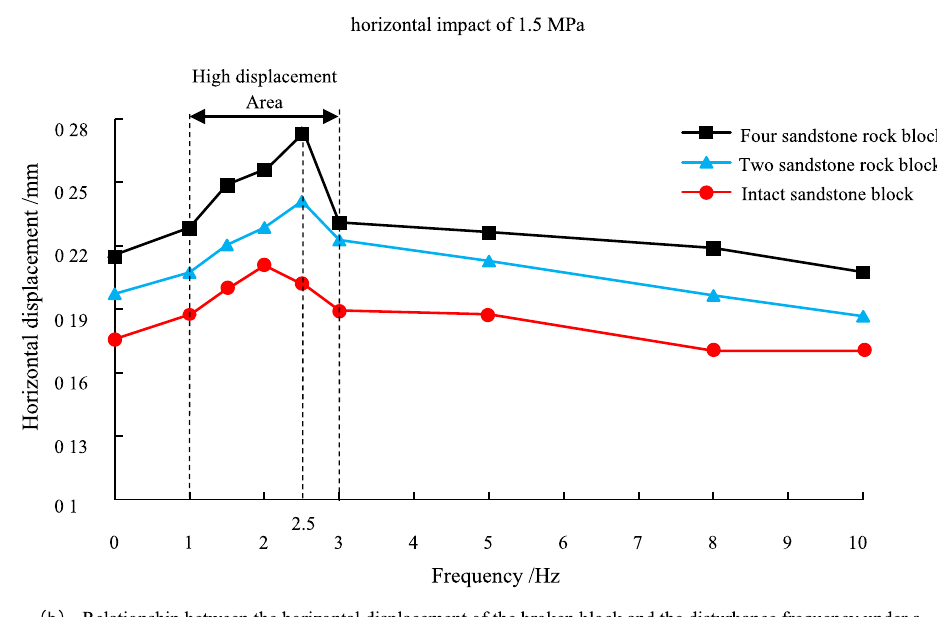
Fig. 7 Relationship between horizontal displacement of broken block and frequency of stress wave-induced